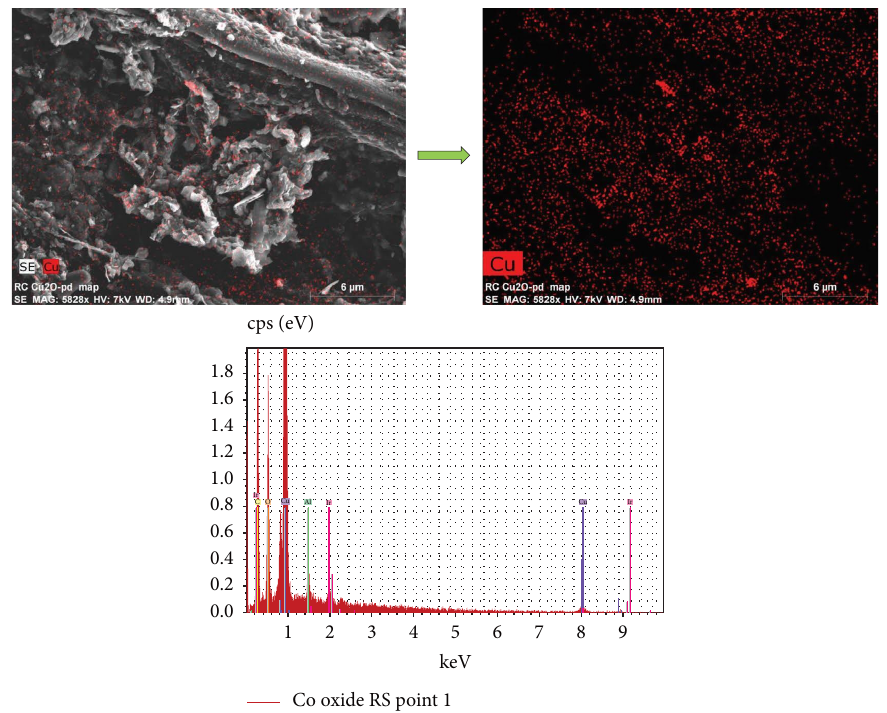
Figure 6: SEM/EDX image of cattail root showing the presence of Cu